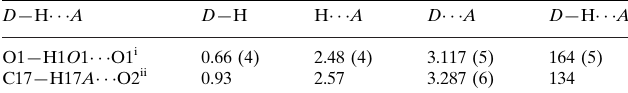
Hydrogen-bond geometry (A˚ , (cid:3)